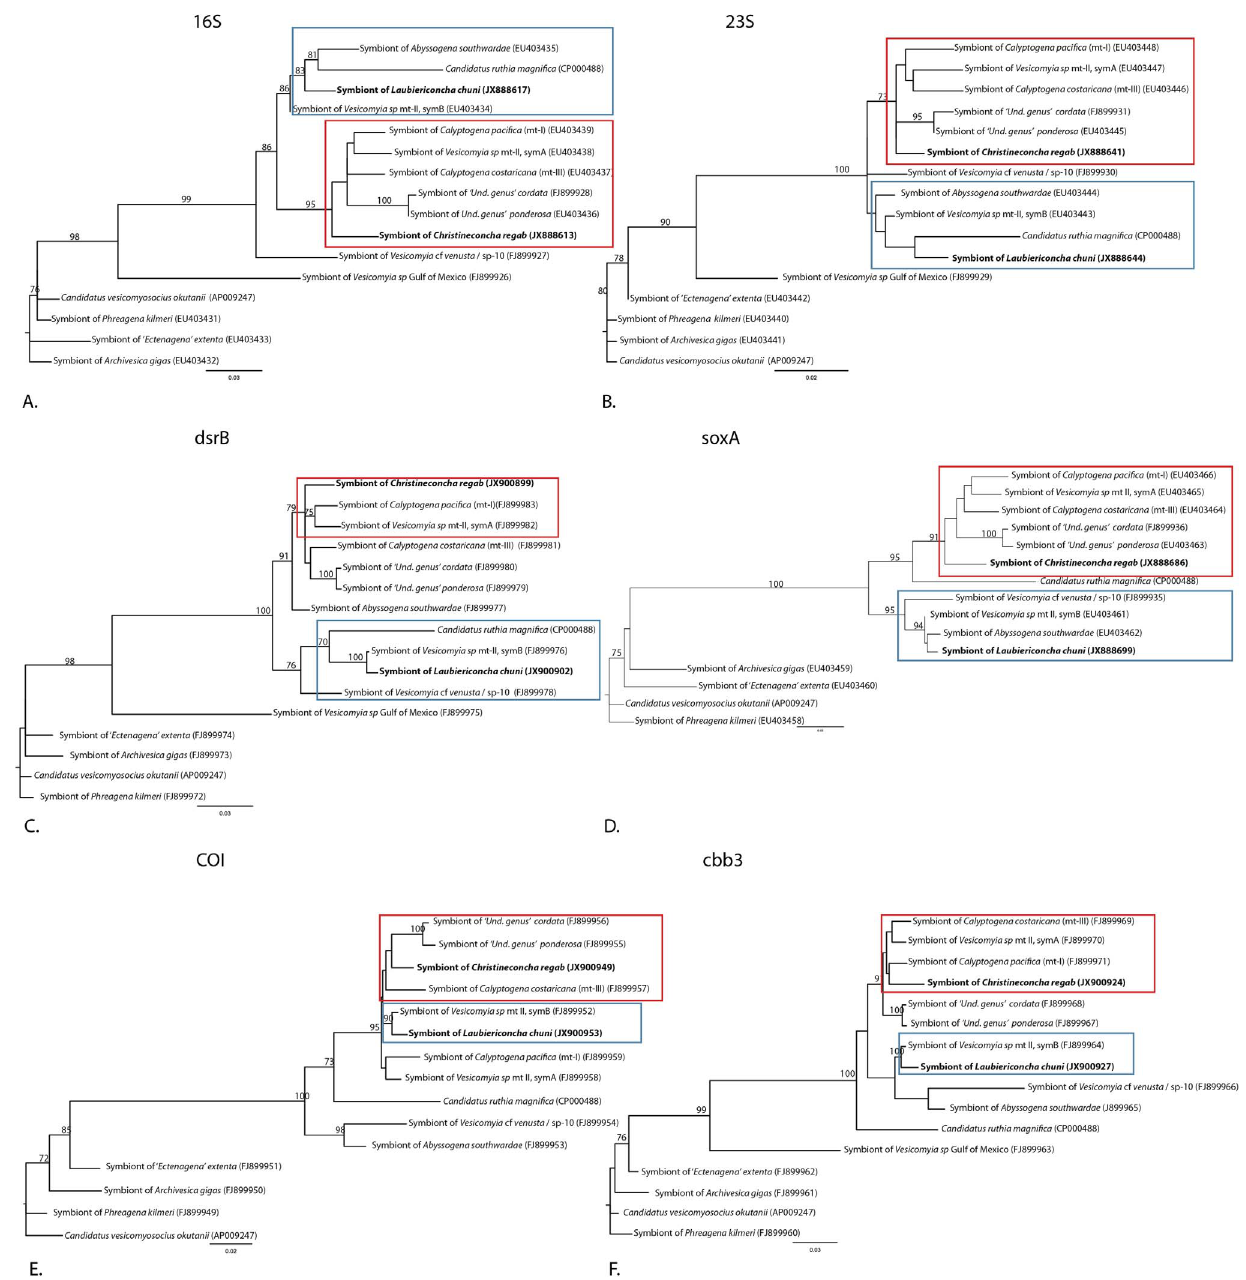
Figure 4. Unrooted maximum-likelihood phylogenies for six vesicomyid symbiont marker genes. Boxes indicate clade designations: L. chuni / Vesicomya sp. mtII symB (blue), C. regab / Vesicomya sp. mtI, mtII symA (red). Bootstrap values for 1000 replicates are given in percent above branches and clades ( . 70% only). Scale bars are expressed as number of substitutions per base pair. The evolutionary model tested was GTR + I + G. with the following parameters: proportion of invariable sites=0.79 (A), 0.56 (B), 0 (C, D, E, F), number of substitution rates (nst)=6 for all phylogenies, gamma distribution parameter=0.84 (A), 1.11 (B), 0.11 (C), 0.32 (D),0.15 (E), 0.14 (F). ‘Und. genus’) indicates a temporary genus name. Sp- 10 corresponds to the species numbers given in Audzijonyte et al.